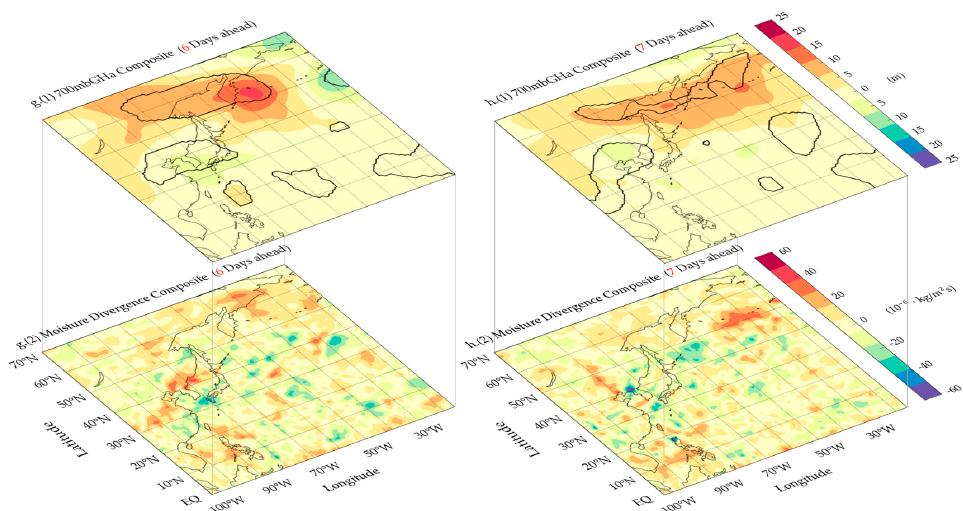
Figure 8. The evolutions of the associated anomalous ( 1 ) atmospheric circulation and ( 2 ) moisture flux during the top 5% extreme precipitation periods using the 700 GHa and VIMFa composites for the Yangtze river basin from 7 days ahead ( h ) to the extreme precipitation days ( a ). The regions with statistical significant values at the 95% level are circled by the thick black lines.